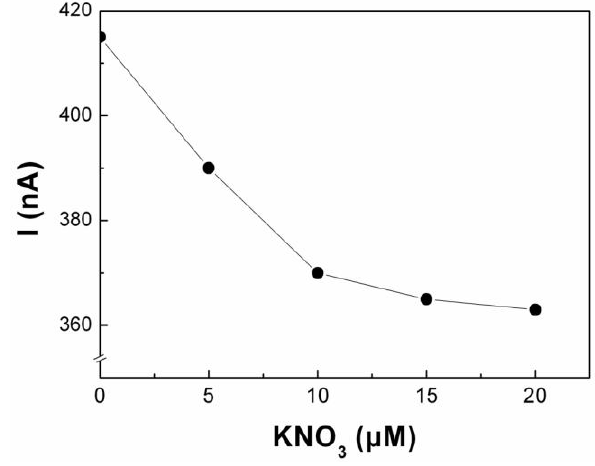
FIGURE 2. Effect of KNO 3 concentrations on the SW current intensity peak for 20 μ Μ imidacloprid in lymphocyte cultures. Blood samples were incubated at 37 o C in the presence of